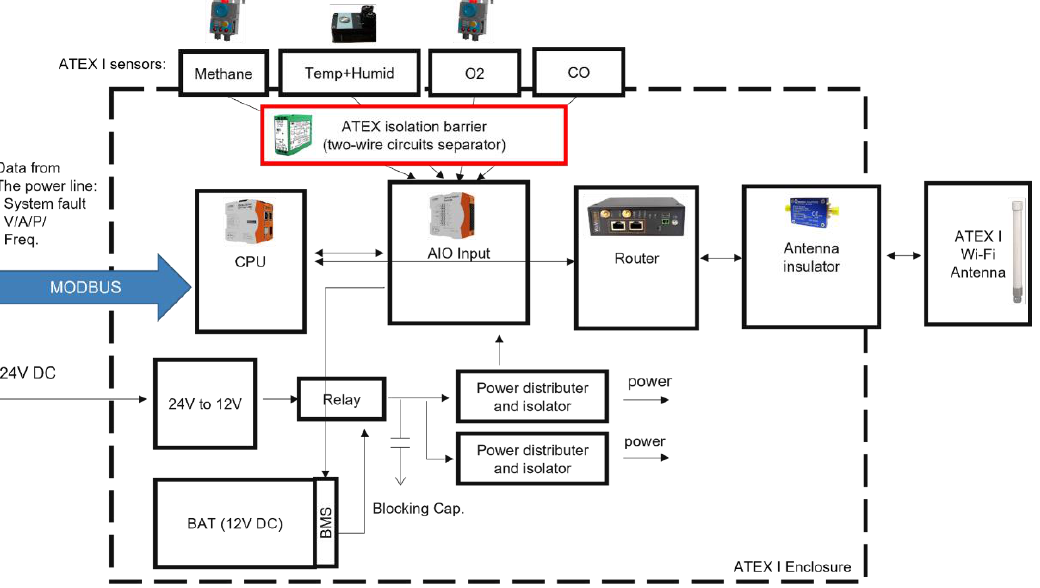
Figure 9. Conceptual block diagram of the access point developed for the monitoring system within the HEET II project, showing the subparts and how they are connected. The CPU collects data from sensors via an analog input–output (AIO) module, and from the energy transmission system via a Modbus interface, and transmits the aggregated data through mesh-capable Wi-Fi routers. The routers create a seamless single wireless network along the suspended rail track for the tractor module to connect